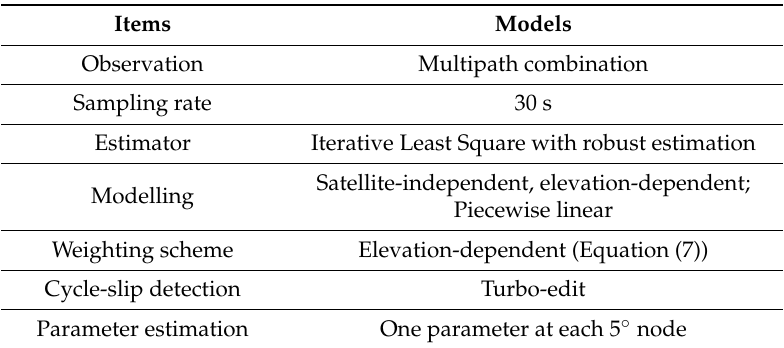
Figure 1. The flowchart of our CMB estimation procedure. Table 1. Models and parameters for BDS CMB